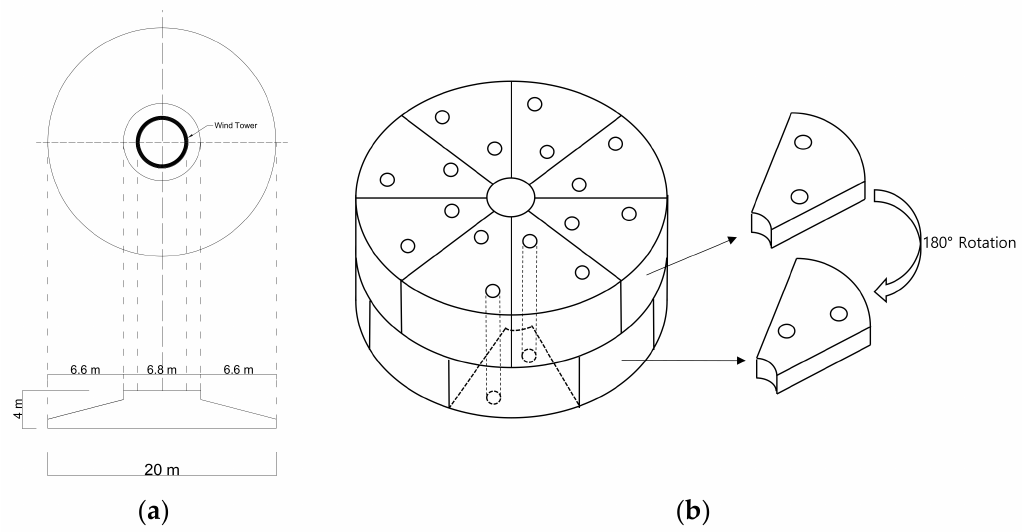
Figure 1. Sectional plan ( a ) and block type model ( b ) for foundation of wind tower.